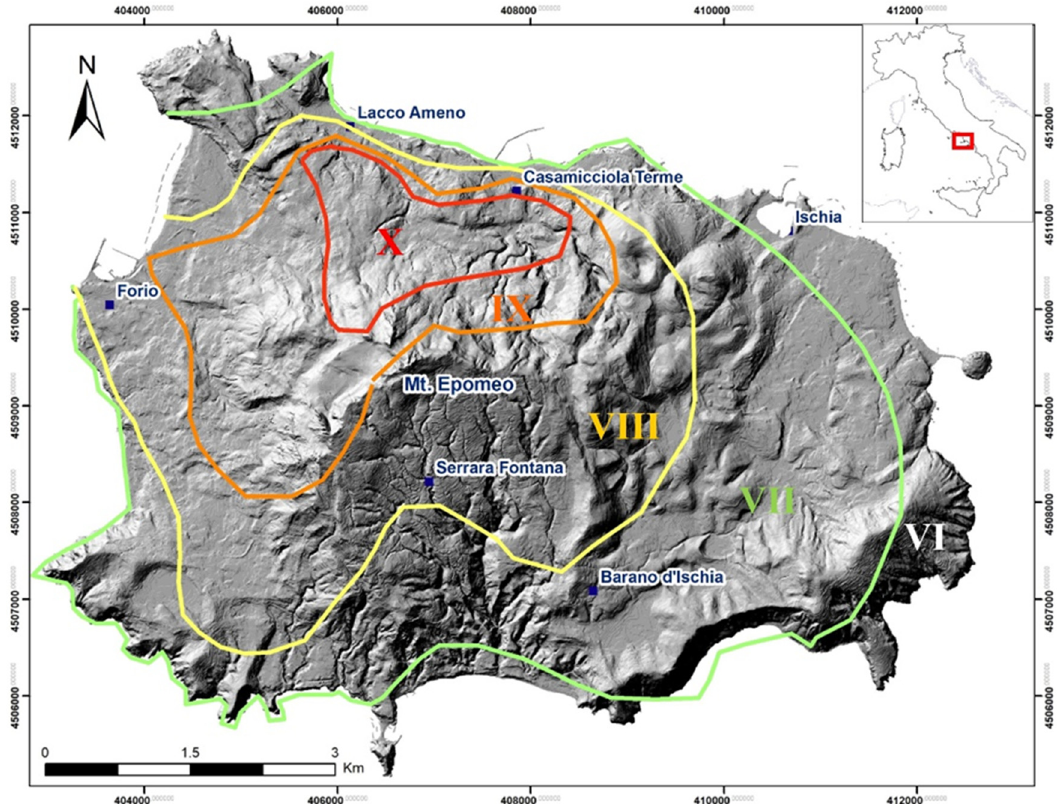
Figure 3. Isoseismal map of the Casamicciola Terme earthquake of 28 July 1883 (MCS scale); the epicentral area of X MCS develops on the N side of Mt. Epomeo, affecting Casamicciola Terme and Lacco Ameno; the isoseismal of greater intensity show an E–W and N–S elongation, while the isoseismal of a lower degree border the Epomeo simulating channeling pro cesses of the seismic energy released at the source [30].